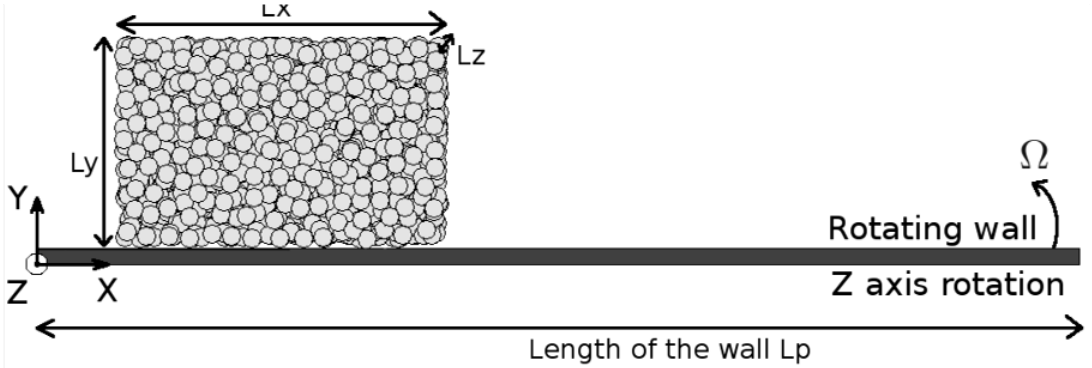
Figure 1. Schematic view of the flow of an assembly of grains along a rotating